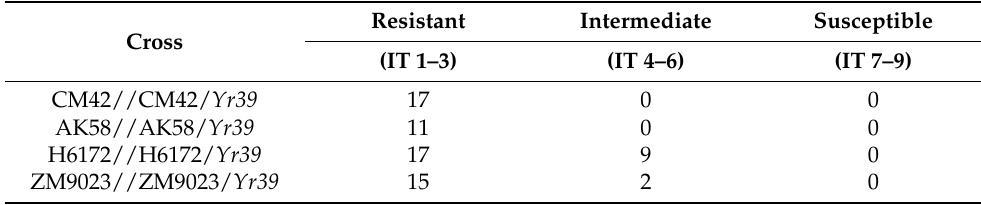
Figure 1. Resistance of parents and lines to stripe rust at adult stage. ( A ): AvS/AlpF 7 -71 ( Yr39 ); ( B ): Chuanmai 42 (CM42); ( C ): Bainong Aikang 58 (AK58); ( D ): Han 6172 (H6172); ( E ): Zhengmai 9023 (ZM9023); ( F , G ): lines from Yr39 /CM42; ( H , I ): lines from Yr39 /AK58; ( J , K ): lines from Yr39 /H6172; and ( L , M ): lines from Yr39 /ZM9023. Table 3. Numbers of wheat lines in different stripe rust infection type (IT) categories developed from four